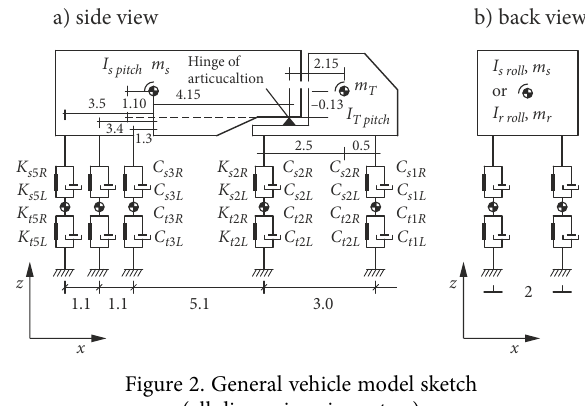
Figure 2. General vehicle model sketch (all dimensions in meters)